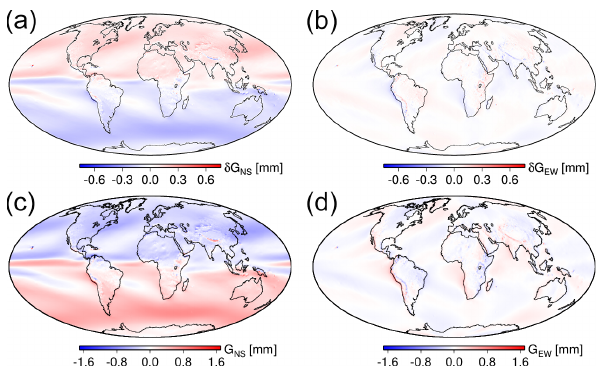
Figure A1. (a, b) Systematic difference (average over 10 years) for any point on Earth’s surface between tropospheric gradients esti- mated utilizing the gradient mapping function of Bar-Sever and tro- pospheric gradients estimated utilizing the gradient mapping func- tion of Chen and Herring. (c, d) Mean north- and east-gradient com- ponents (average over 10 years) for any point on Earth’s surface utilizing the mapping function of Chen and Herring. Panels (a) and (c) show the north-gradient component, (b) and (d) the east-gradient component. The results are based on ERA5